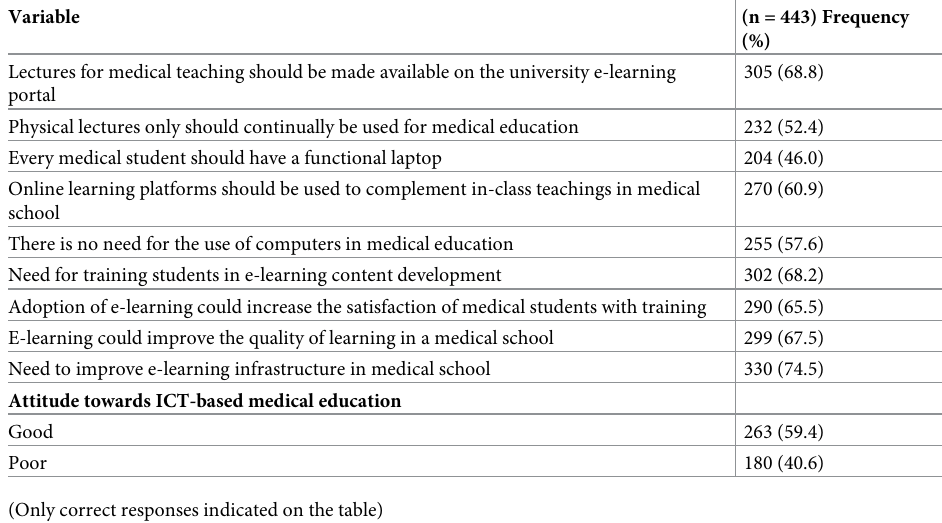
(Only correct responses indicated on the